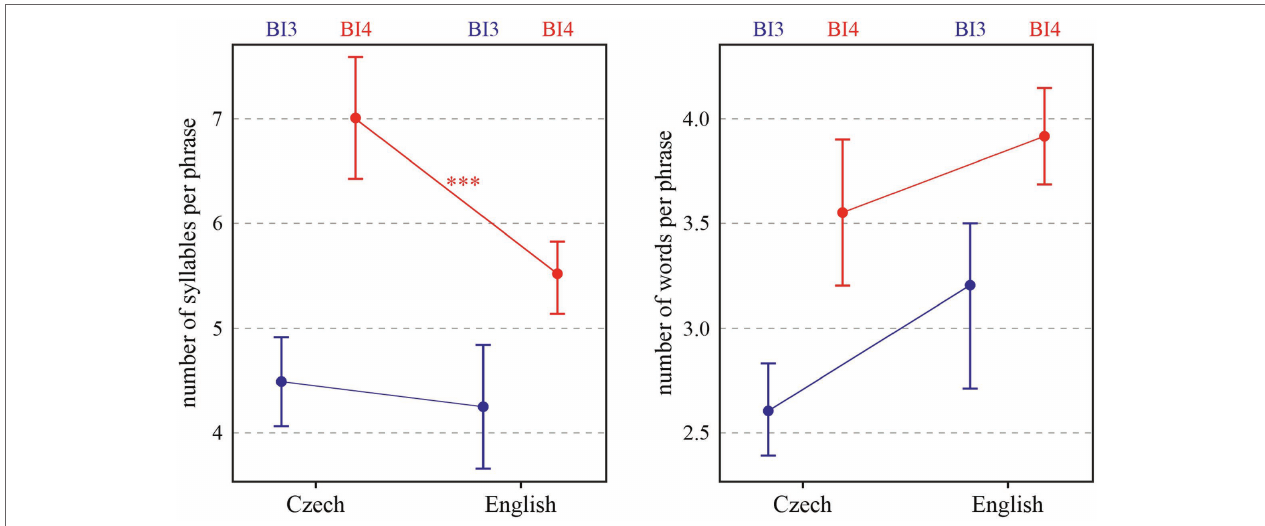
FIGURE 1 | Number of syllables (left) and words (right) per prosodic phrase depending on L anguage and P rosodic break type (BI3 in blue; BI4 in red). *** p <